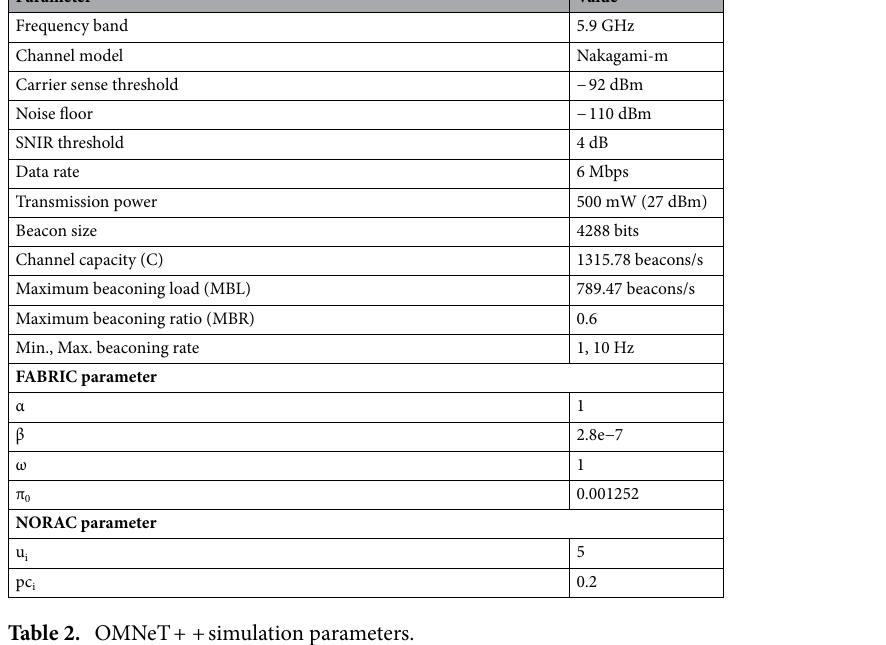
Table 2. OMNeT + + simulation